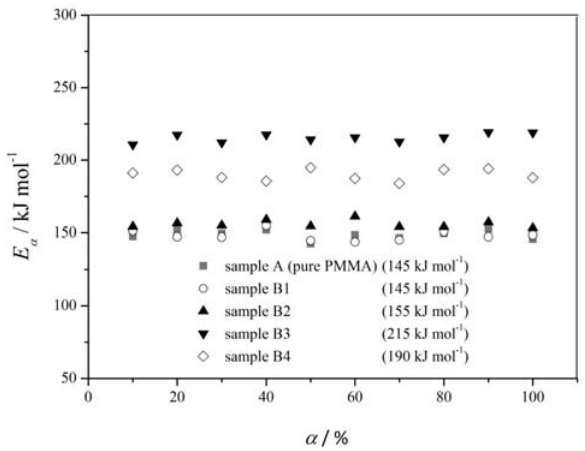
Figure 8. E vs α relationship for B-series ZnO-PMMA composi- a tes (PMMA is added for the comparison)